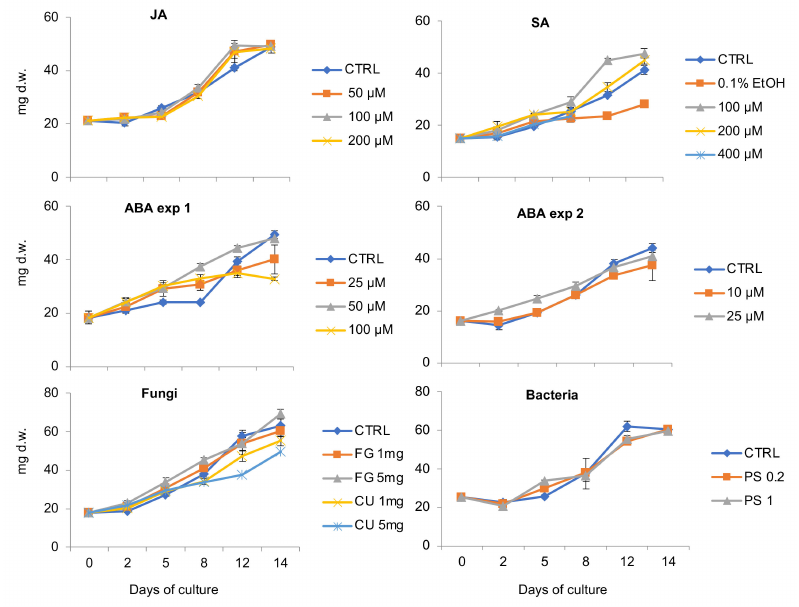
Figure 1. Growth curves for V. uliginosa cell suspension cultures treated with plant stress hormones (JA, SA, ABA) and the biotic elicitors, neutralized fungi (FG— Fusarium graminearum and CU— Colletotrichum utrechtse ) and bacteria (PS— Pseudomonas syringae )–in different concentrations. All treatments were compared with the untreated controls